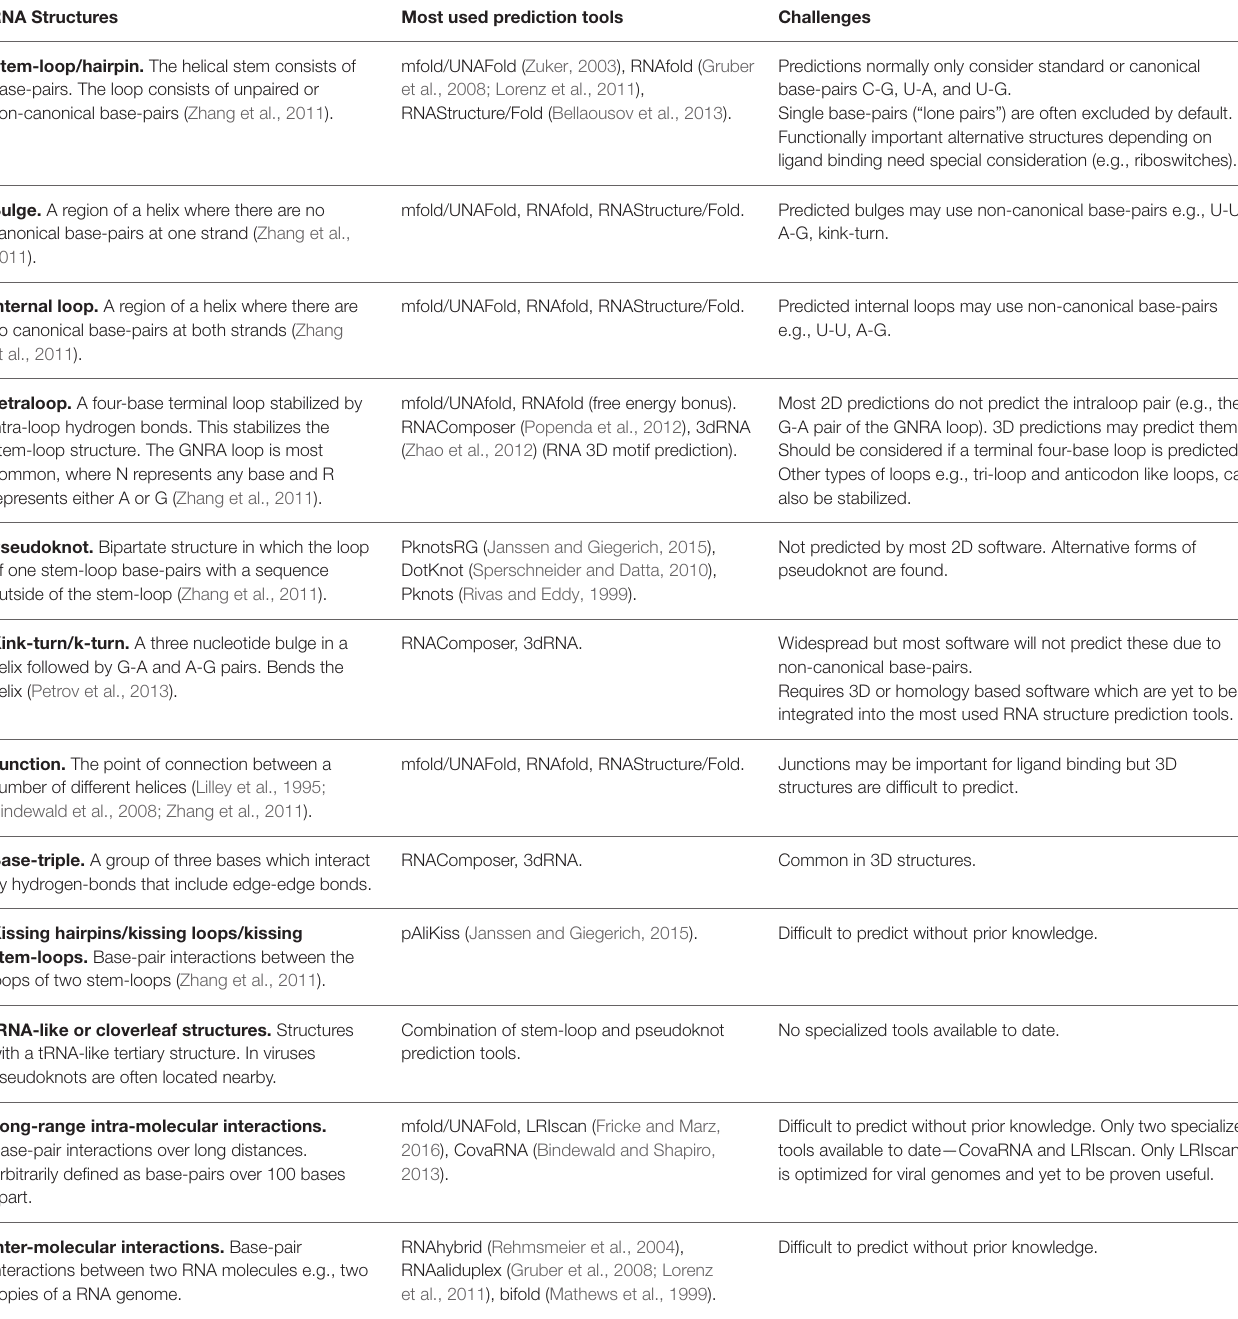
TABLE 1 | Structural RNA elements, the most used prediction tools, and challenges for their prediction. RNA